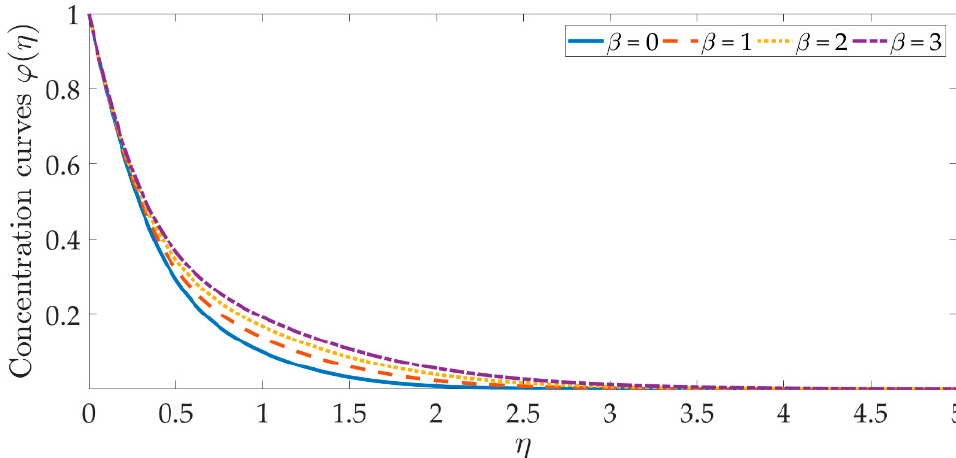
Figure 17. Concentration curves against the multiple values of β .